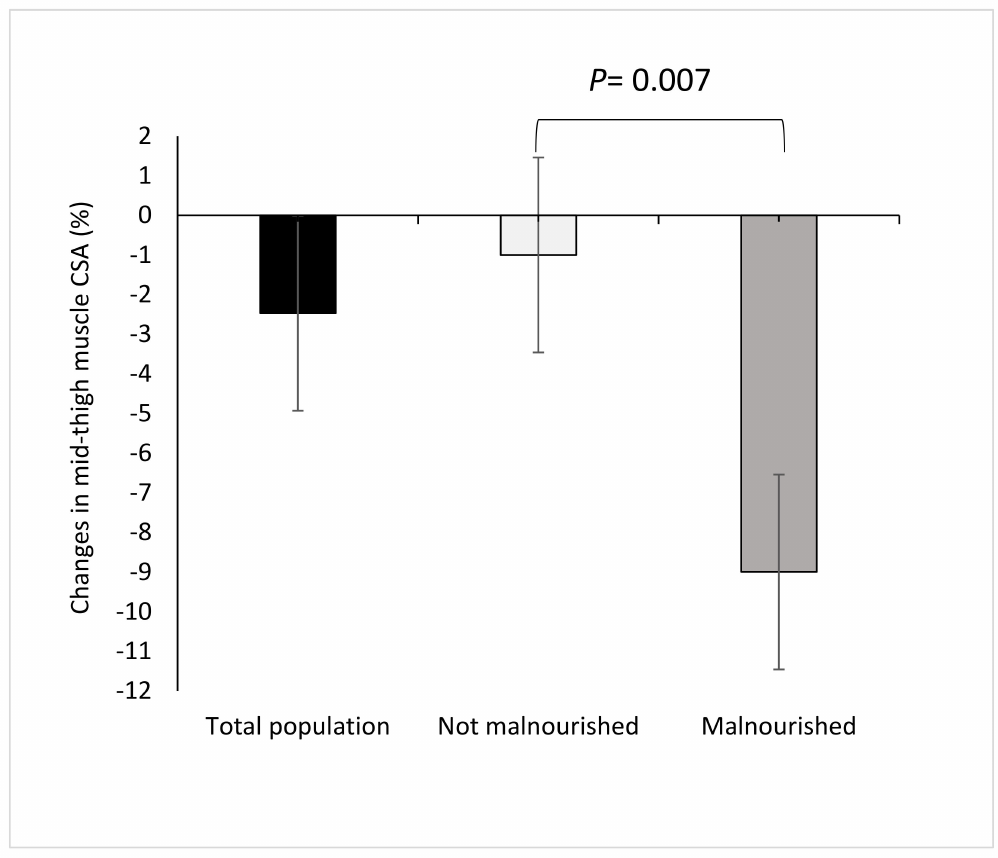
Figure 2. Changes in mean mid-thigh muscle cross sectional area (CSA) as a percentage of initial muscle area during hospitalization in total population ( n = 41), in malnourished ( n = 7) and non-malnourished ( n = 34) patients according to Global Leadership Initiative on Malnutrition (GLIM)